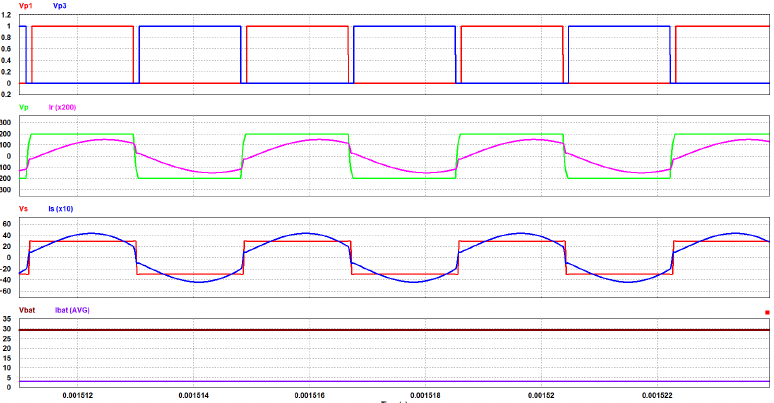
Figure 13. LLC resonant converter FM simulation V o = 29.4 V, I o = 3 A, f sw = 270